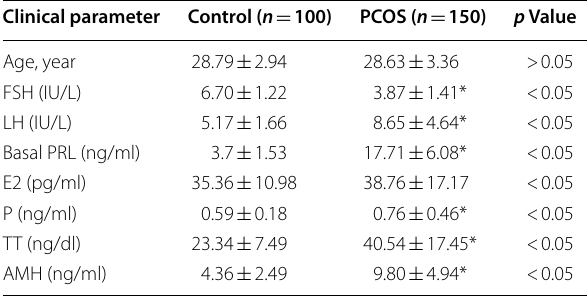
Table 1 Hormonal and anthropometric data of PCOS patients and the control